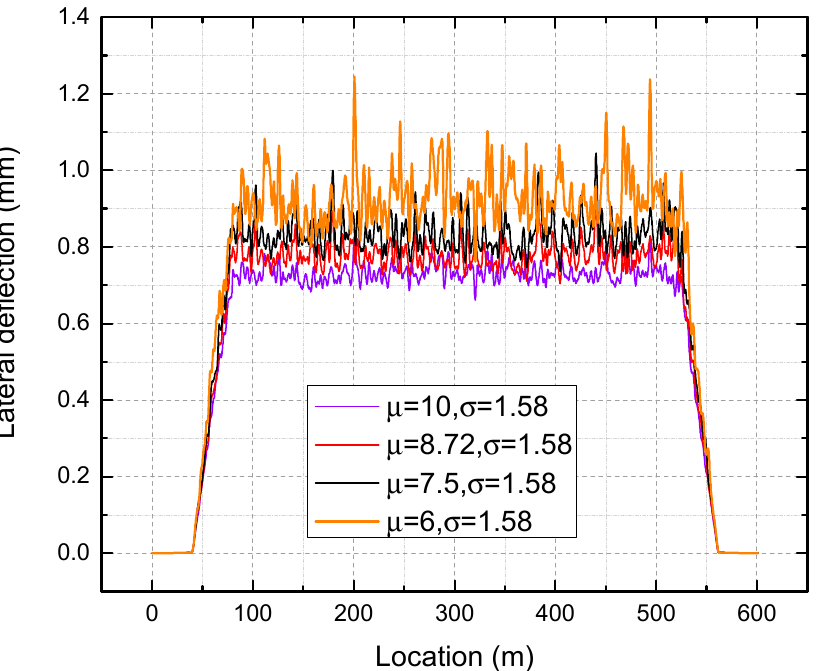
Figure 16. Lateral deflection under different mean values.